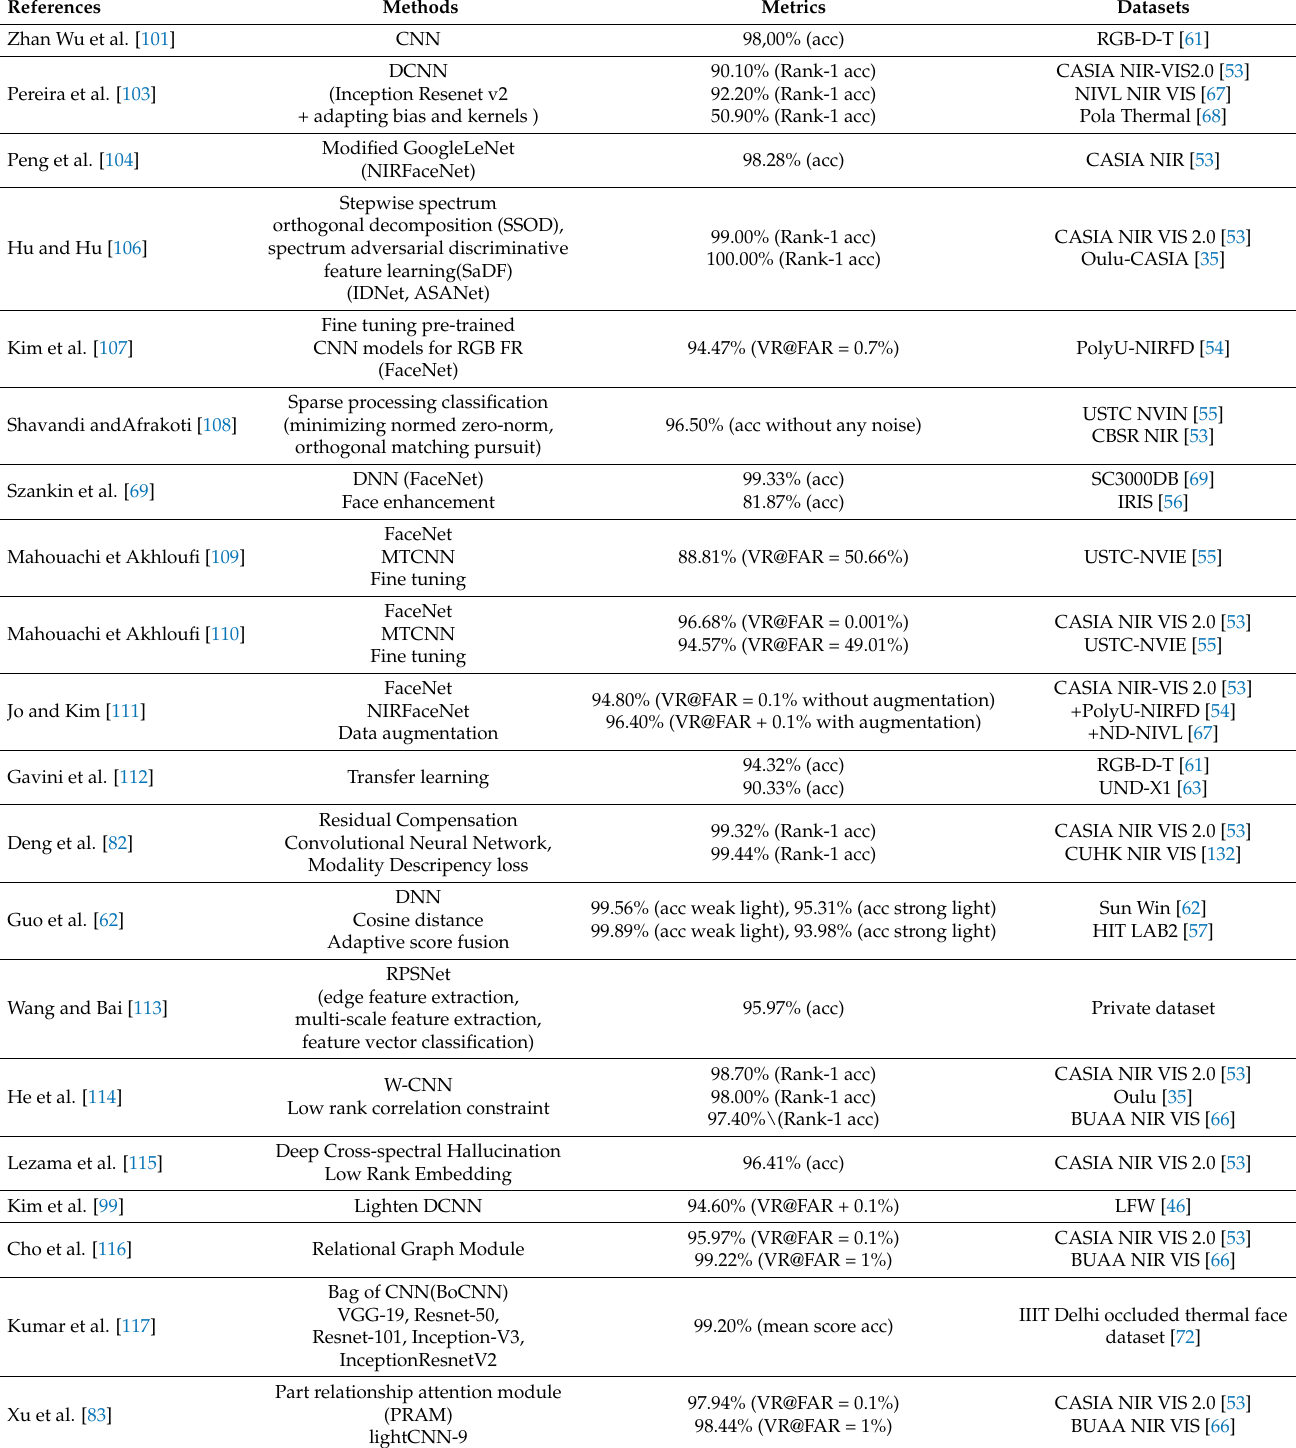
Table 3. Comparison of feature extraction approaches